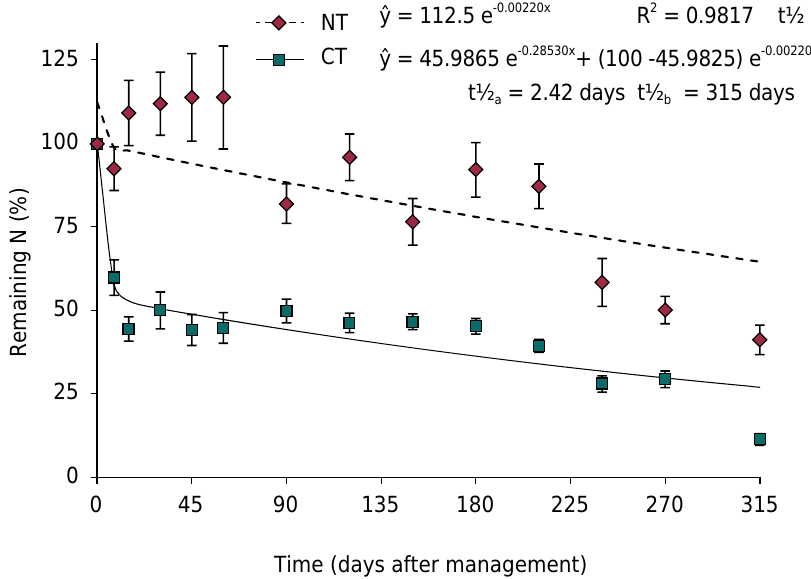
Figure 4. Means of remaining nitrogen of aboveground phytomass after management of three mixtures of cover crops in mango interrows in Petrolina, Pernambuco, Brazil (PM1 = 75 % leguminous species + 25 % grass and oilseed species; PM2 = 25 % leguminous species + 75 % grass and oilseed species; and SV = spontaneous vegetation) under two soil tillage systems (NT = no tillage; CT = conventional tillage); t ½ = half-life time; t½ a = half-life time of more easily decomposable compartment; t ½ b = half-life time of recalcitrant compartment. Bars represent the standard error of the mean.